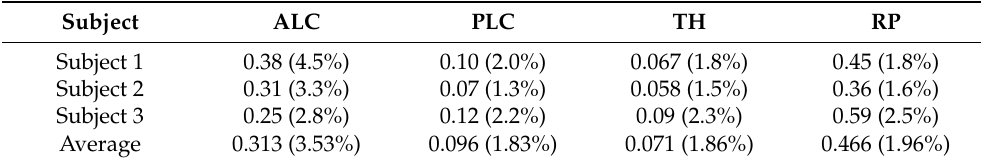
Table 3. Average difference and difference rate between the accommodation process of finite element model and real lens (average difference/mean of